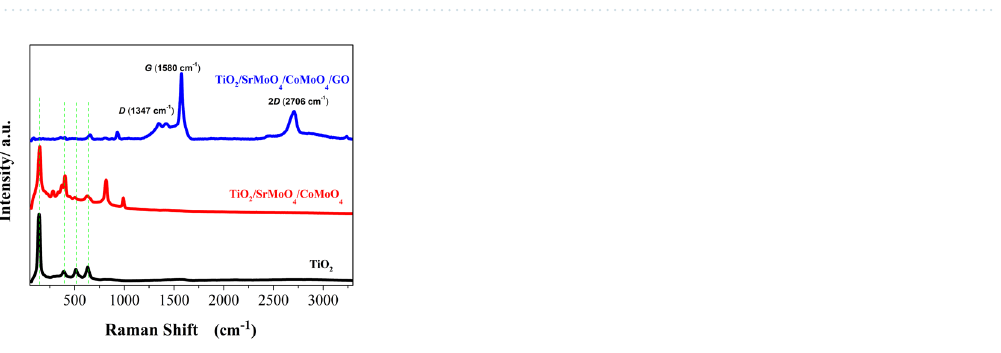
Figure 4. X-ray diffraction spectra of samples: ( a ) TiO 2 /SrMoO 4 /GO, ( b ) TiO 2 /CoMoO 4 /GO, ( c ) TiO 2 / SrMoO 4 /CoMoO 4 /GO.